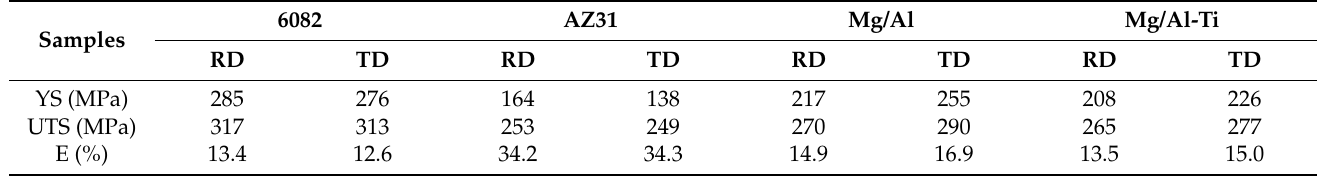
Figure 8. Engineering stress–strain curves under tension along the RD and TD of ( a ) as-rolled composite sheets, and ( b ) raw sheets. Table 1. Tensile properties of the raw sheets and composite sheets along the rolling direction (RD) and transverse direction (TD). YS, UTS, and E represent yield strength, ultimate tensile strength, and elongation, respectively.